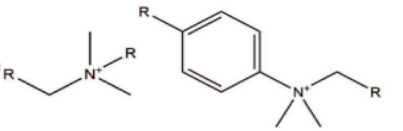
Figure 1. General chemical structure of quaternary ammonium compounds (QACs).